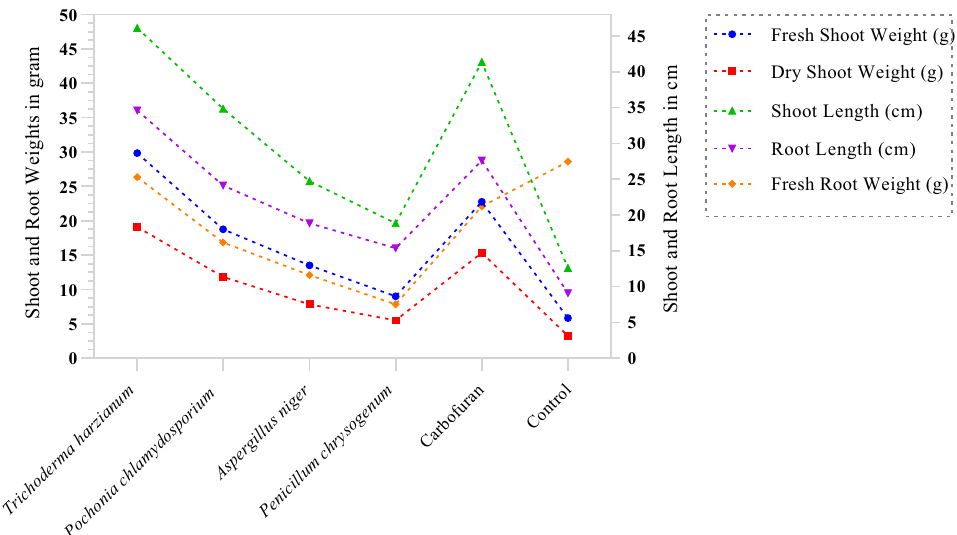
Fig. 5 Effects on the eggplant growth parameters after the addition of various fungal biocontrol agents inoculated with Meloidogyne incognita at the in-planta